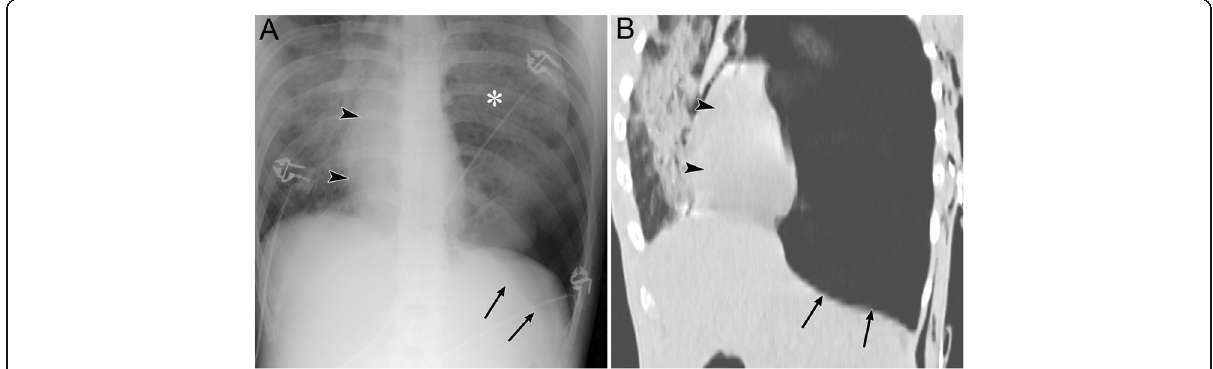
Fig. 7 Tension pneumothorax due to traffic trauma in an 18-year-old man. a A supine radiograph shows left pneumothorax with a rightward mediastinal shift (black arrowheads) and partly inverted left hemidiaphragm (black arrows). The left lung is collapsed with a contusion (asterisk). b A coronal CT image clearly depicts a rightward mediastinal shift (black arrowheads) and an inverted left hemidiaphragm (black